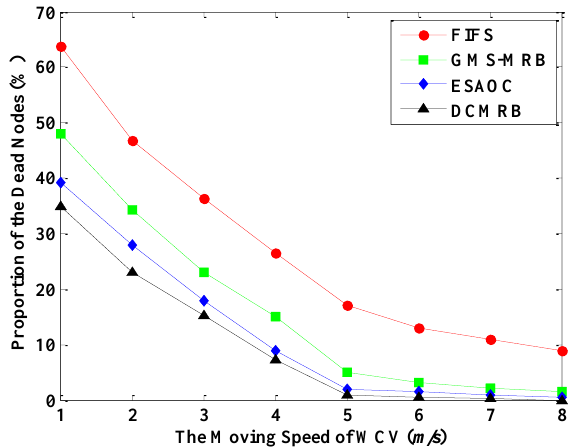
Figure 24. Proportion of the dead nodes under different moving speeds.